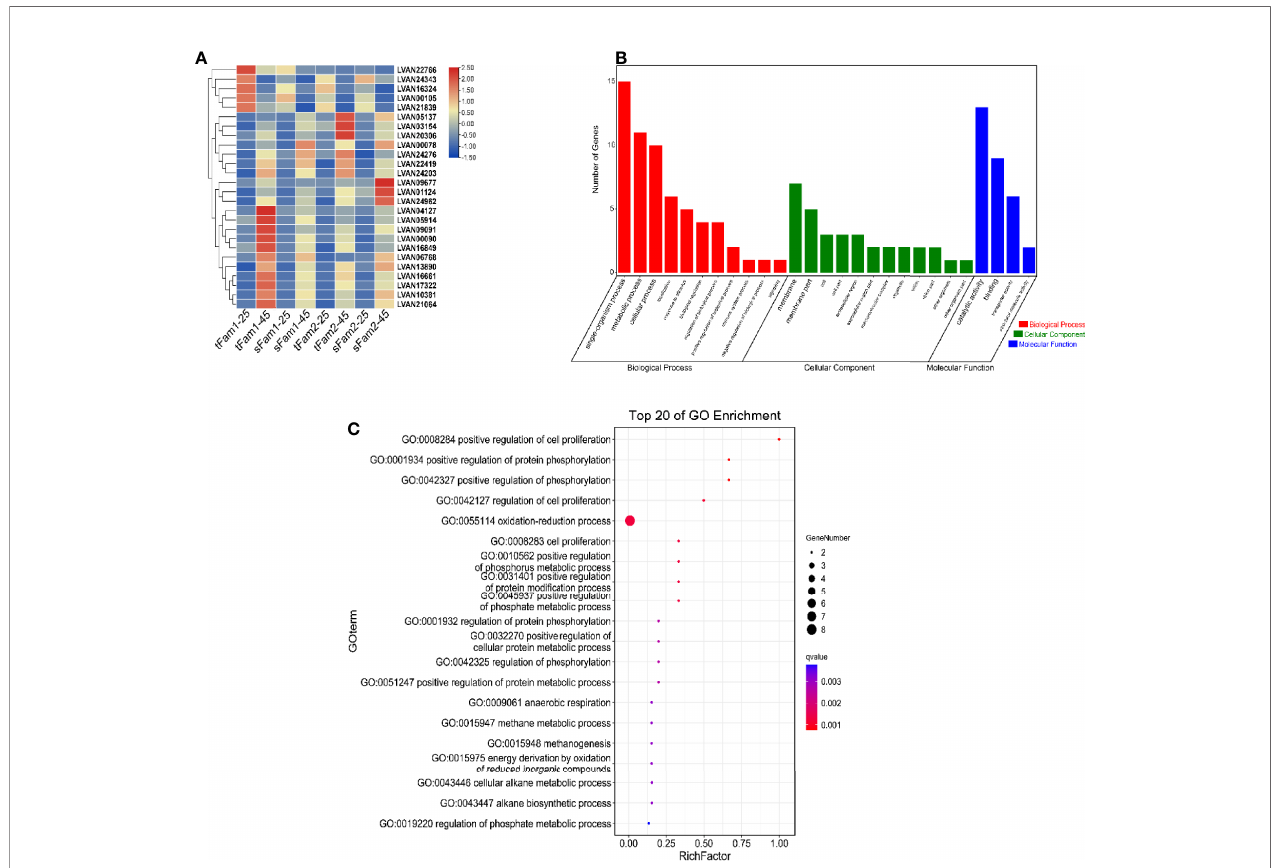
FIGURE 3 | DEGs for high-salinity tolerant families and susceptible families after high-salinity stress in Litopenaeus vannamei . (A) Gene expression heatmap of DEGs with similar expression pattern in four families. (B) GO enrichment analysis of DEGs. (C) Top 20 GO terms enriched in the categories of biological process for DEGs; the point color shows different Q values as indicated on the right. DEGs, differentially expressed genes; GO, Gene